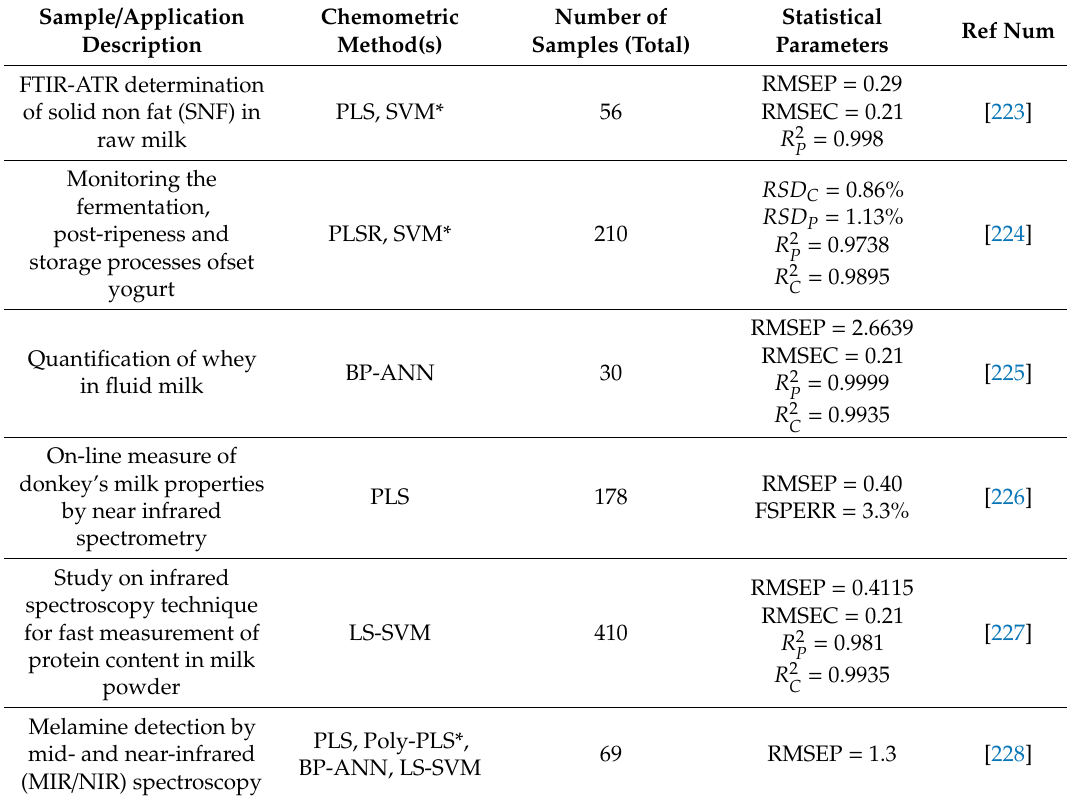
Table 13. Literature related to the use of chemometrics in prediction of properties of dairy